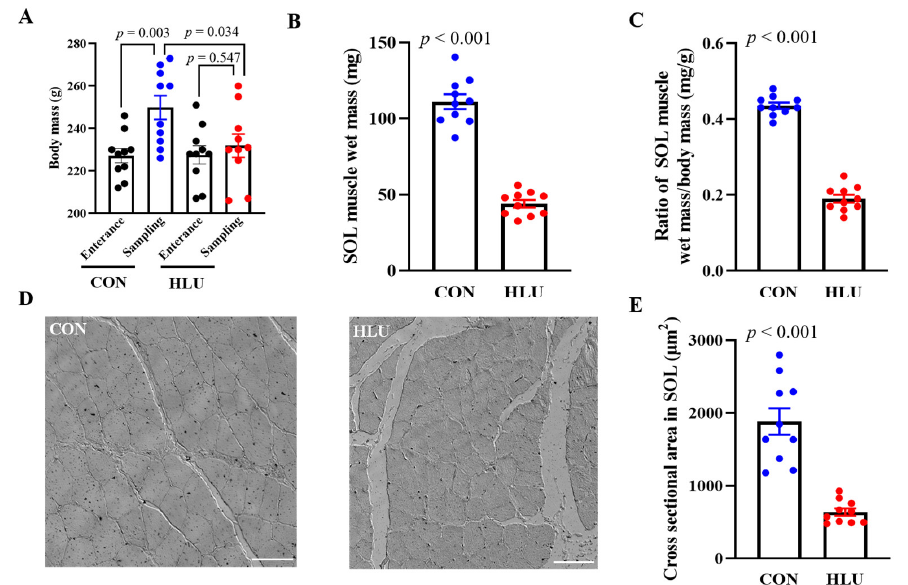
Figure 1. Changes of body and muscle mass and muscle cross-sectional area. ( A ) Changes of body mass. ( B ) Changes of SOL muscle wet mass. ( C ) Changes in ratio of SOL muscle wet mass/body mass. ( D ) Transection image of muscle fiber. ( E ) Changes in cross-sectional area (CSA). Each circle represented a value. n = 10. Data were analyzed by t -test. Data are shown as Mean ± SEM and con- sidered statistically significant at p < 0.05. Scale bar, 60 μm.